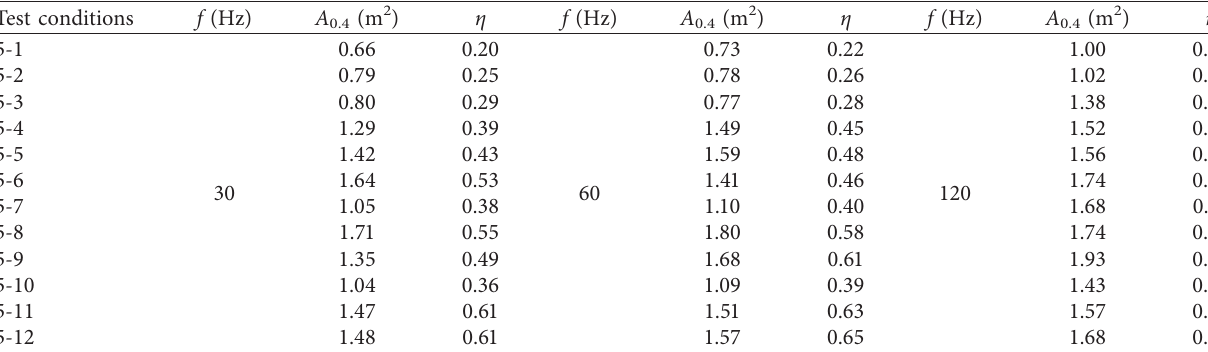
Figure 13: Amplitude reduction ratio contour map for test conditions (a) 5-1, (b) 5-4, (c) 5-8, and (d) 5-12. Table 14: List of vibration isolation